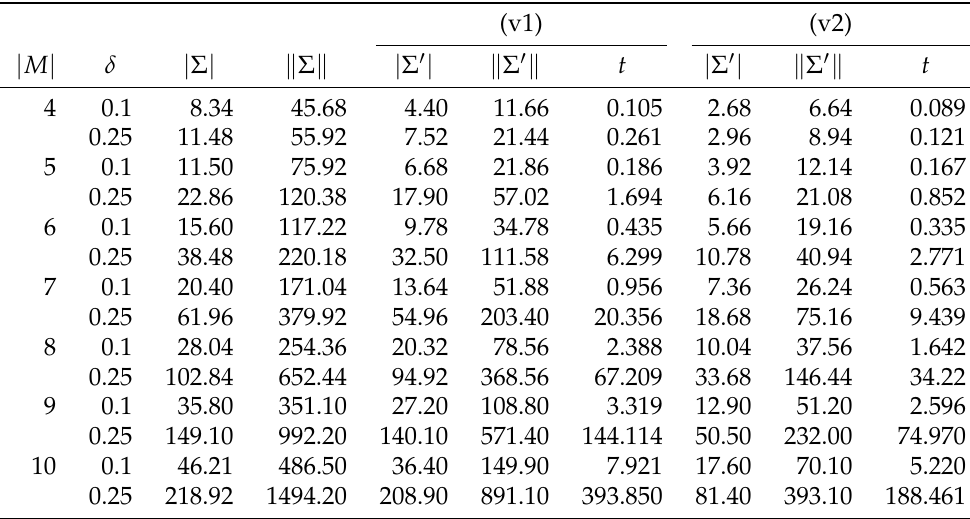
Table 1. Data from the experimental evaluation. Columns 3 to 10 express the average value obtained in the experiments for each of the studied parameters (cardinality, size and execution